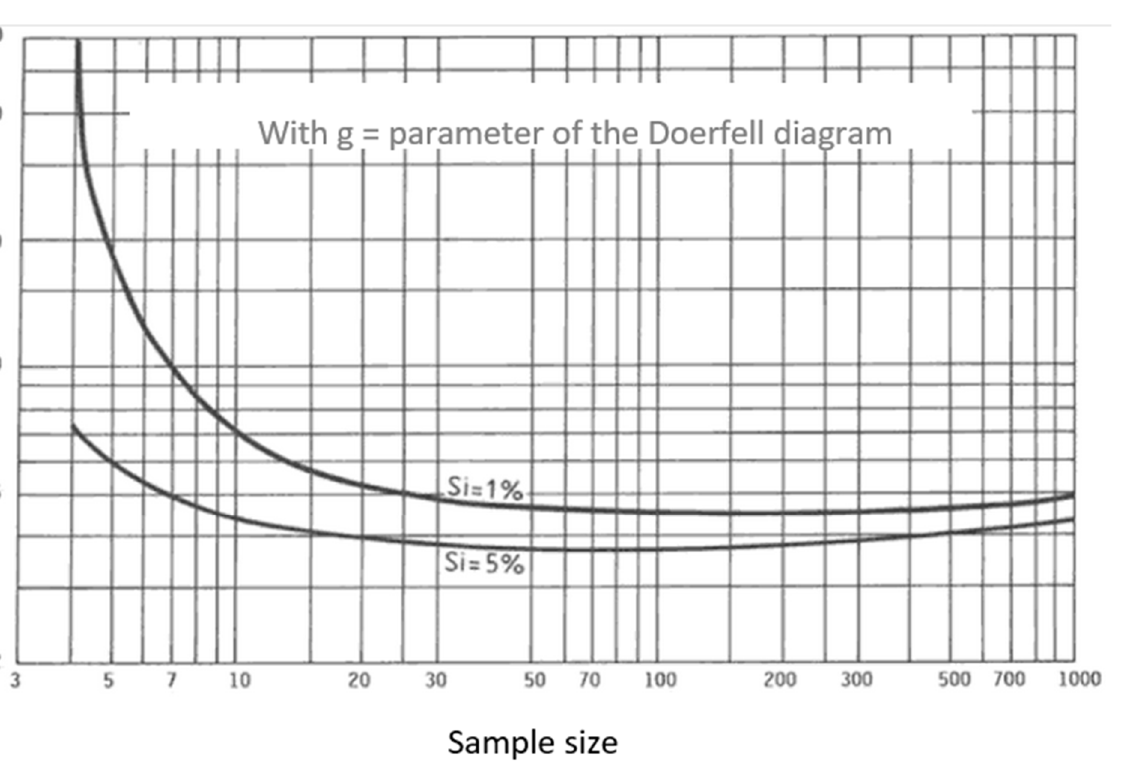
Figure 4. Generalized stratigraphy for the Saguenay-Lac-Saint-Jean region (modified from [13]).